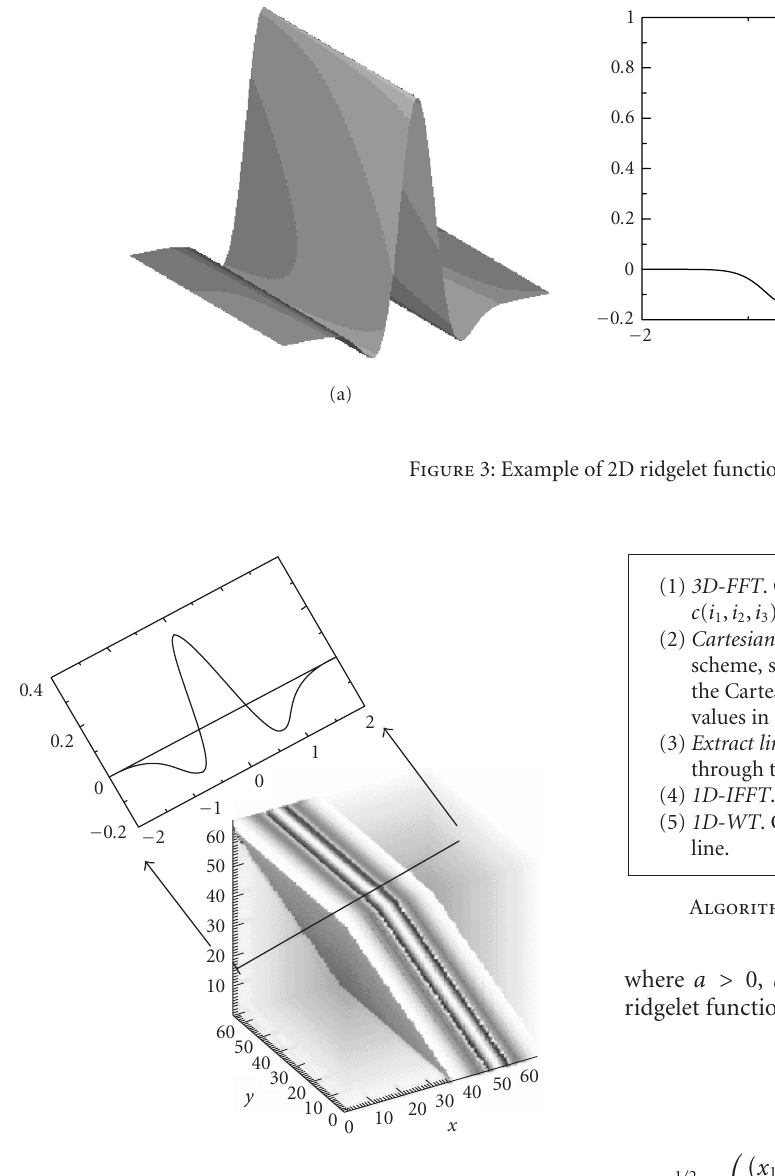
Figure 4: Example of ridgelet function.